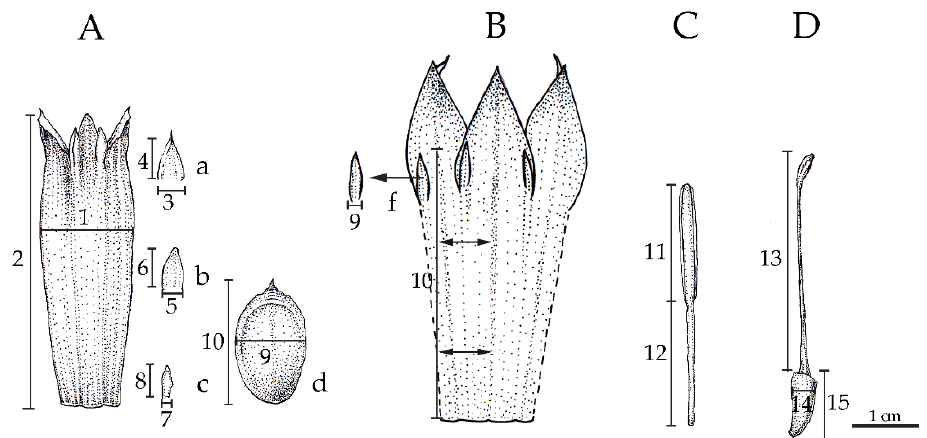
Figure 10. Quantitative characters of banana flowers. ( A ), Perianth of bilateral flower of banana including ( a ) lateral outer tepal, ( b ) median outer tepal, ( c ) later inner tepal and ( d ) median inner tepal (free tepal) of all Musaceae except M. nanensis , ( B ), perianth of M. nanensis that ( f ) median inner tepal fused with perianth tube, ( C ), stamen and ( D ,) pistil, i.e., 1. width of fused tepal, 2. length of fused tepal, 3. width of lateral outer tepal lobe, 4. length of median outer tepal lobe, 5. width of central outer tepal lobe, 6. length of central outer tepal lobe, 7. width of inner tepal lobe, 8. length of inner tepal, 9. width of median inner tepal, 10. length of median inner tepal, 11. length of anther, 12. length of filament, 13. length from style base to stigma head, 14. width of ovary, 15. length of ovary. Scale bar = 1 cm.